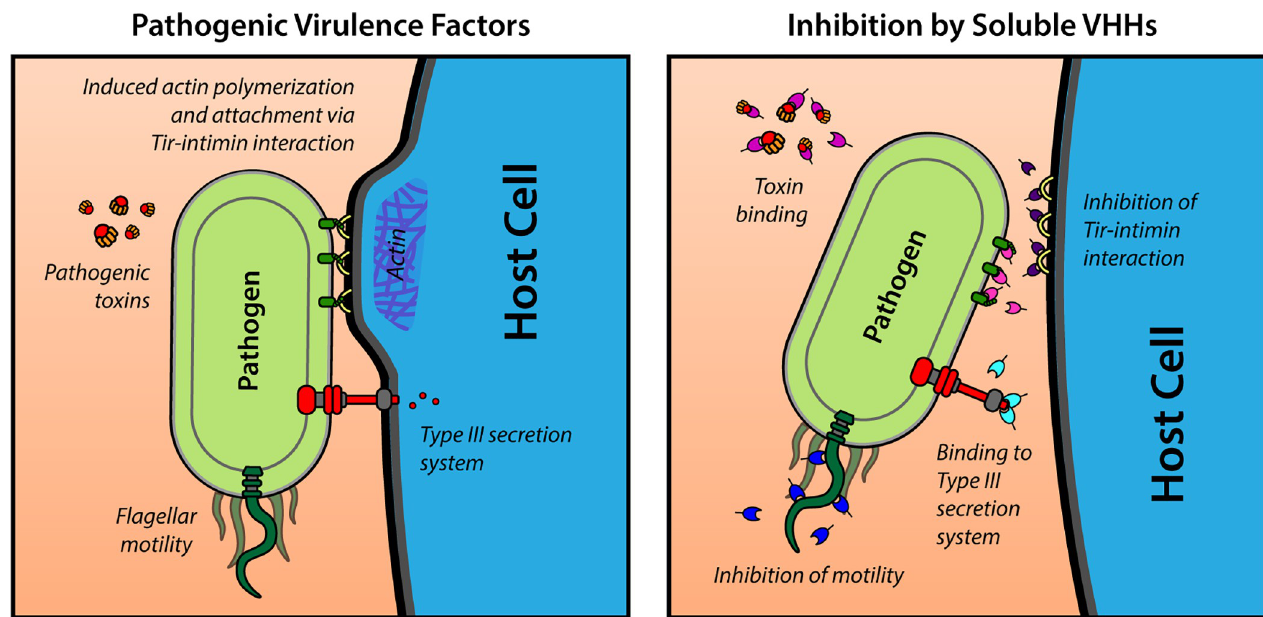
Fig 1. Schematic overview of bacterial virulence factors used as VHH targets in this study.